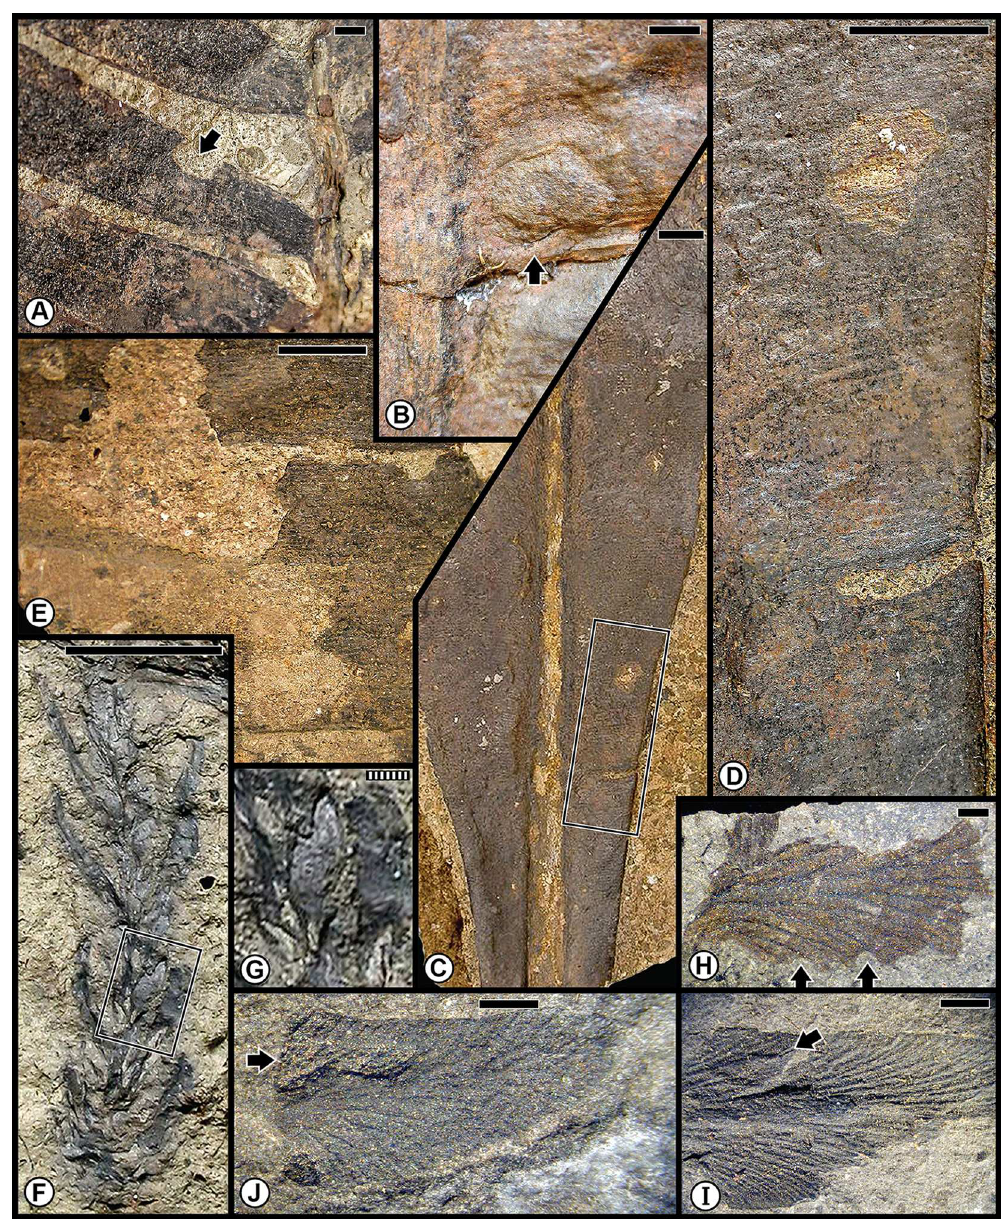
Fig 10. Plant–insect interactions from the Middle Triassic (Ladinian) Monte Agnello Flora, of the Vulcanites near Predazzo in the central Dolomites. A : The cycadophyte Nilssonia neuberi , displayingcuspate margin feeding (DT12), indicatedby the arrow. Specimen MGP-191-6A. B : Another example of Nilssonia neuberi , exhibitingan example of a scale mark DT77. Specimen MGP-194-72A. C : The cycadophyte Bjuvia sp., showing examplesof surface feeding(DT31) and margin feeding (DT15) along the right margin of the blade. D : Enlargement of polylobatesurface feeding (DT31) from the upper template and trenched margin feeding (DT15) from the template in (C). E : A second example of Bjuvia sp., showingsuccessive examplesof surface feeding (DT29) on the three lower pinnules. Specimen MGP-196-43. F : The coniferophyte Voltzia sp., showinga gall indicatedin the rectangulartemplate. Specimen MGP-171-81. G : Enlargement of the beaked gall (DT121) from the template in (G), showingstructure very similar to that described[19] for a walchianconifer. H : A Phlebopteris sp. pinnuledisplayingcuspate margin feeding(DT12) along its lower border (arrows). SpecimenMPG-191-64. I : A Phlebopteris sp. pinnuleexhibiting a DT106 gall along midveinal area. Specimen MPG-194-84. J : A Phlebopteris sp. pinnulewith a gall at arrow (DT106) occupying the area between the midveinalaxis and pinnuleedge. Specimen MPG-194-83. All specimens are reposited in the Museo della Geologiadi Predazzo, and the Museum of Nature South Tyrol (MNS), Italy. Scale bars: striped = 1 mm; solid = 10